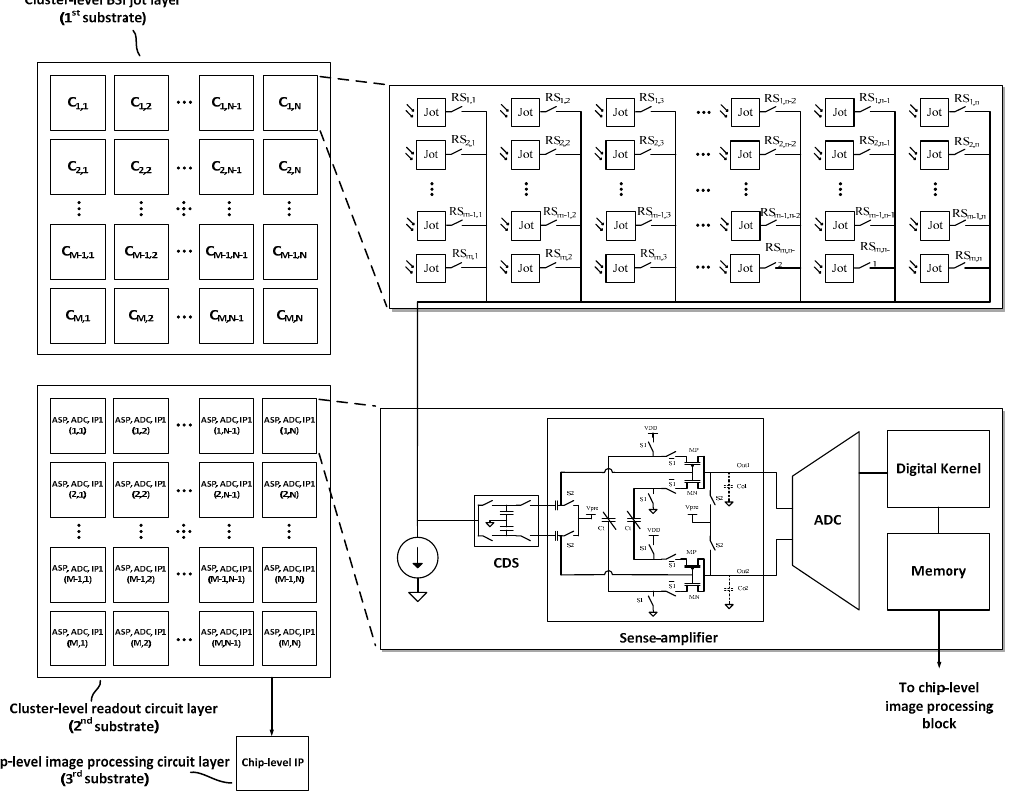
Figure 17. Block diagram of jot clusters, readout circuits and image processing layers.